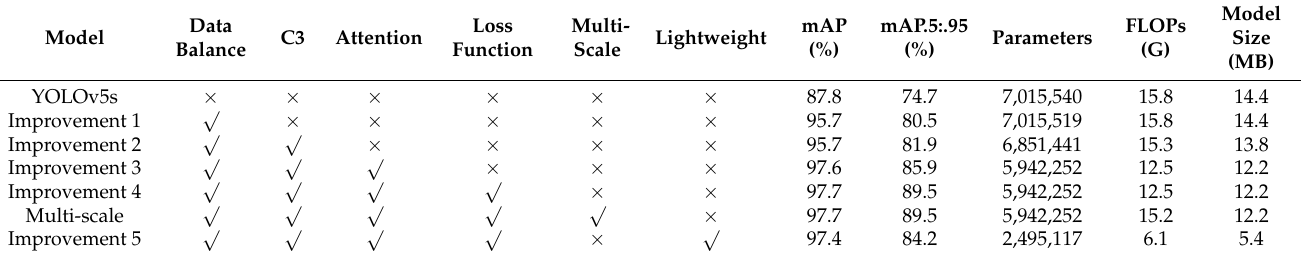
Table 8. Improved network ablation experiments. “ applied in the model. “ × ” means that the improved method is not used in the model. Loss Multi- Attention Lightweight Function Scale